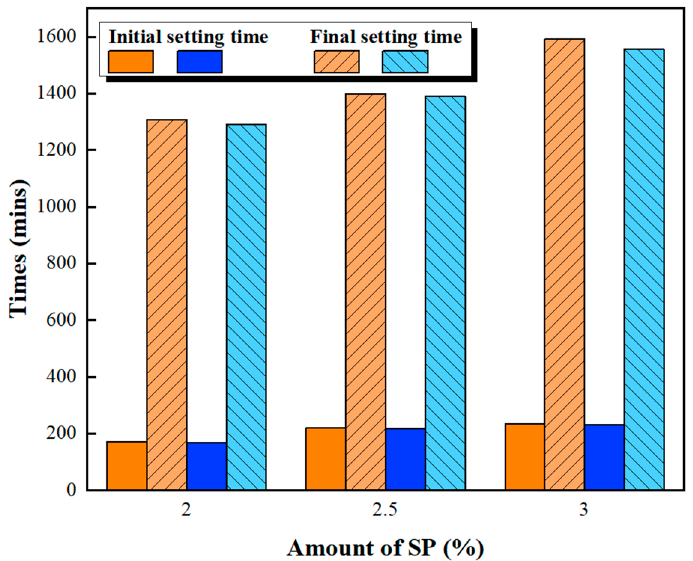
Figure 5. Setting time of green and ecofriendly grouting material with W/B = 0.35.